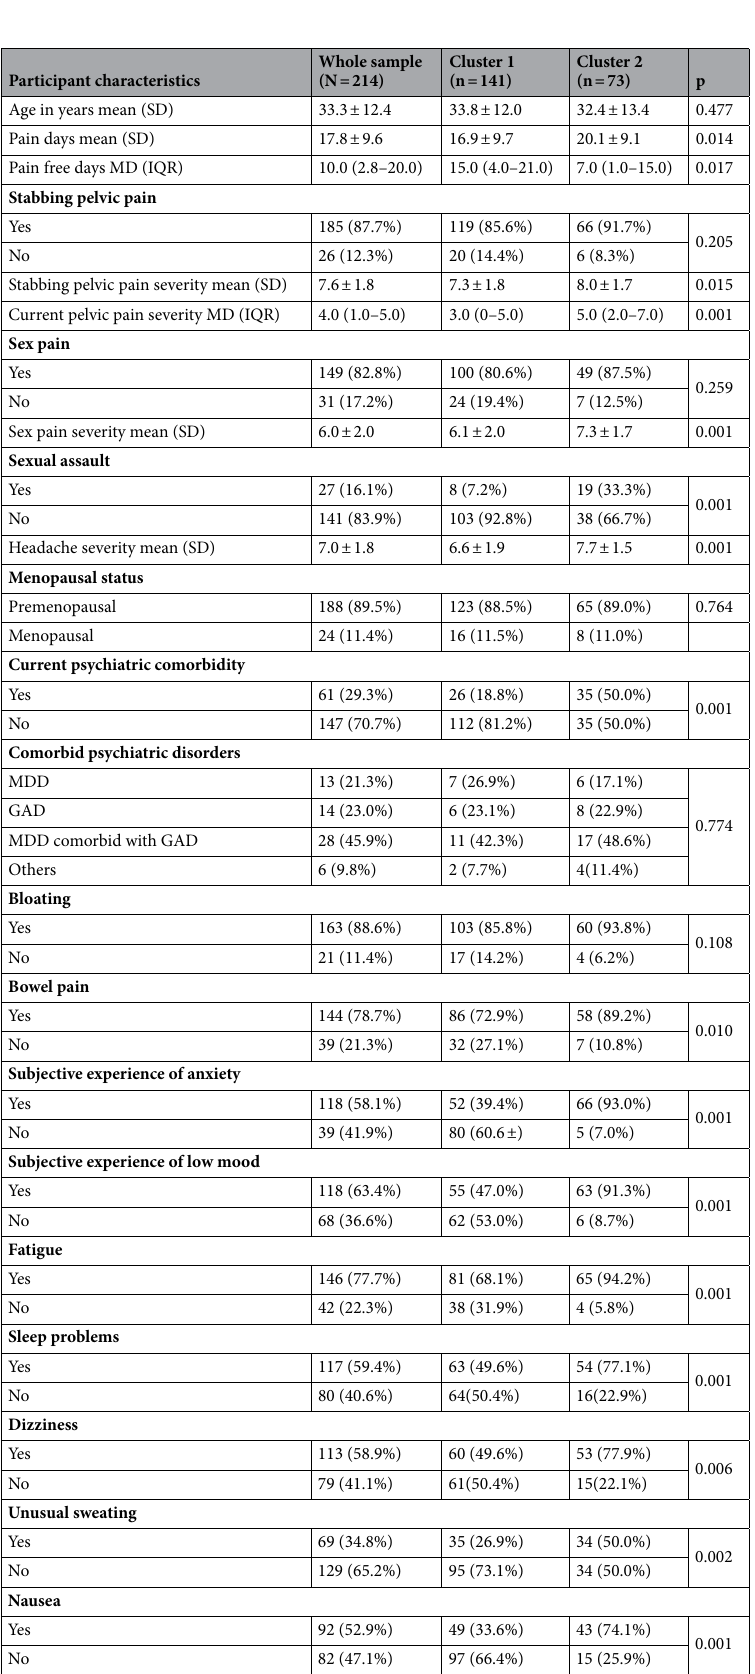
Table 1. Sociodemographic and clinical characteristics of the participants. N ranges between 127 and 211, SD: standard deviation, MD: median, IQR: interquartile range, MDD: Major depression disorder, GAD: Generalized anxiety